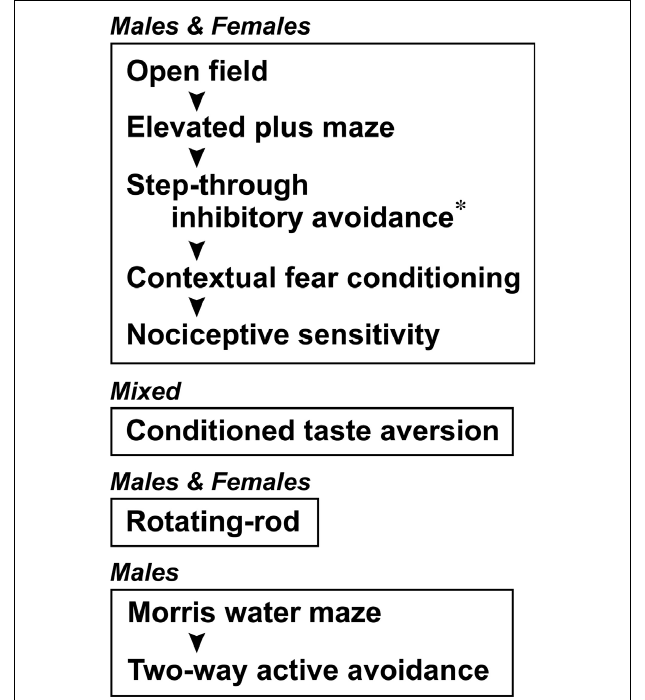
FIGURE 1 | The sex of the mice used for behavioral analysis and the testing procedure order are shown. Each frame indicates an independent group of mice used for the analysis. The asterisk indicates that only male mice were analyzed in the step-through inhibitory avoidance